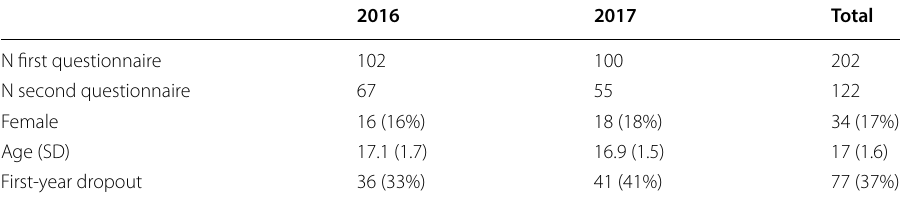
Table 1 Descriptive statistics of the two used cohorts